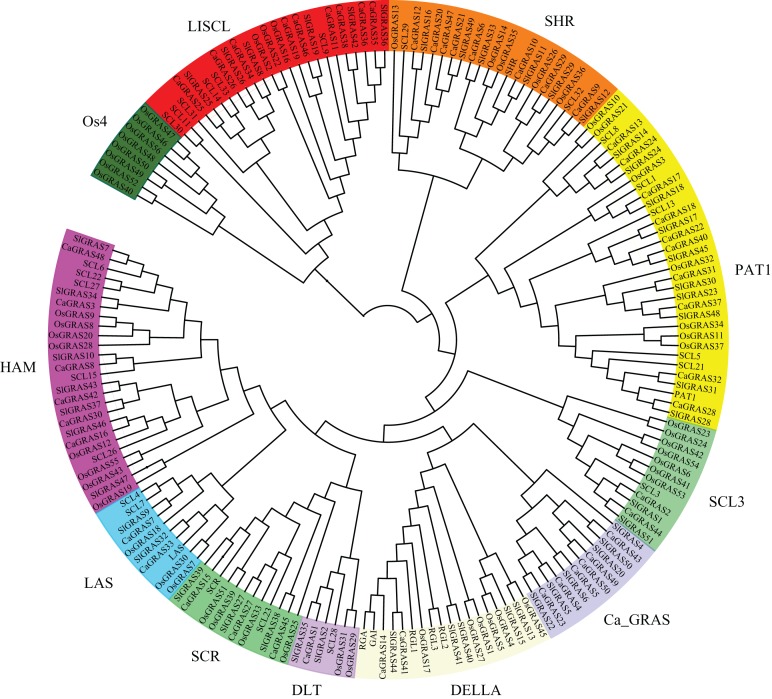
Phylogenetic analyses of GRAS proteins from pepper, tomato, rice and Arabidopsis.The phylogenetic tree was constructed using neighbor-joining (NJ) method by MEGA6.0. Subfamilies were indicated by different colors.